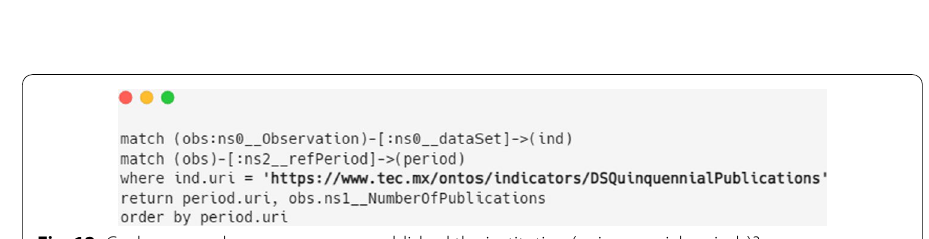
Fig. 12 Cypher query: how many papers published the institution (quinquennial periods)?